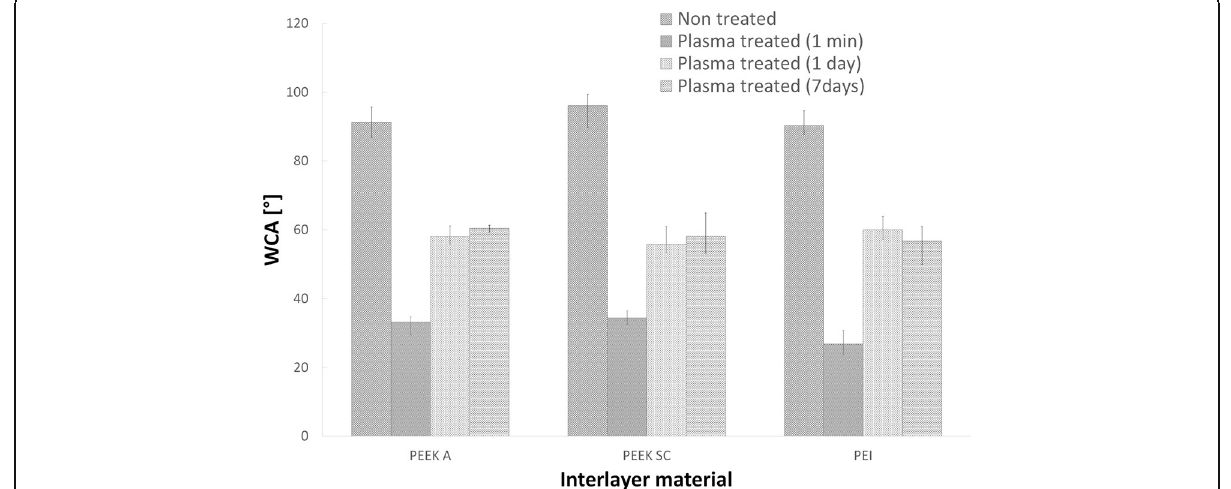
Fig. 8 Wettability depending on waiting time after plasma treatment